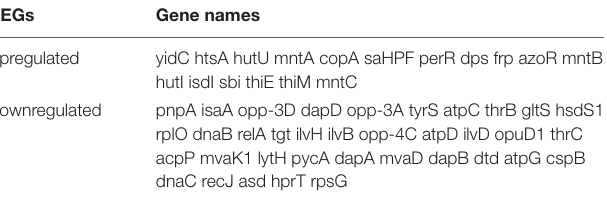
TABLE 3 | Screening DEGs in stationary phase by integrated microarray.